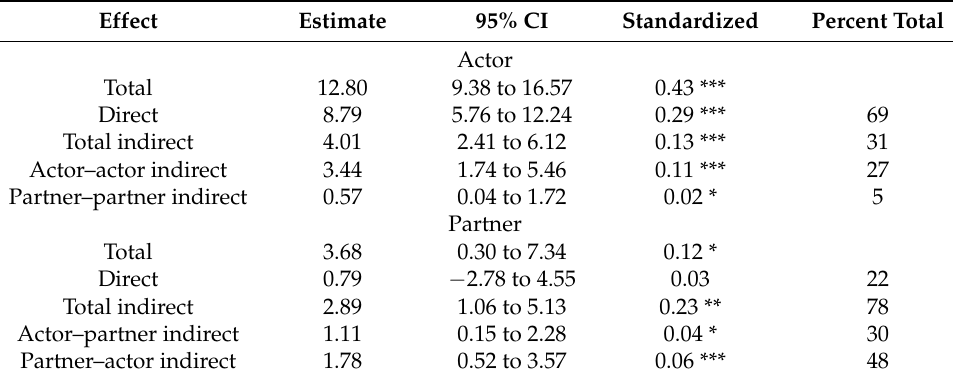
Table 5. Effects of other-perceived supportive DC